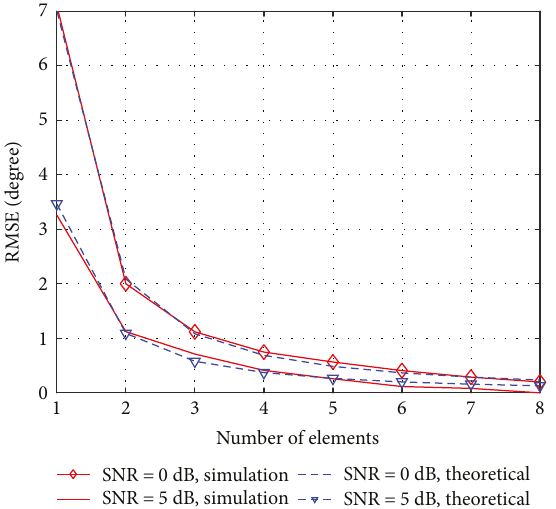
Figure 2: The RMSE value of the DOA estimation versus the spacing in dual MCL antenna array with signal coming from 30 °